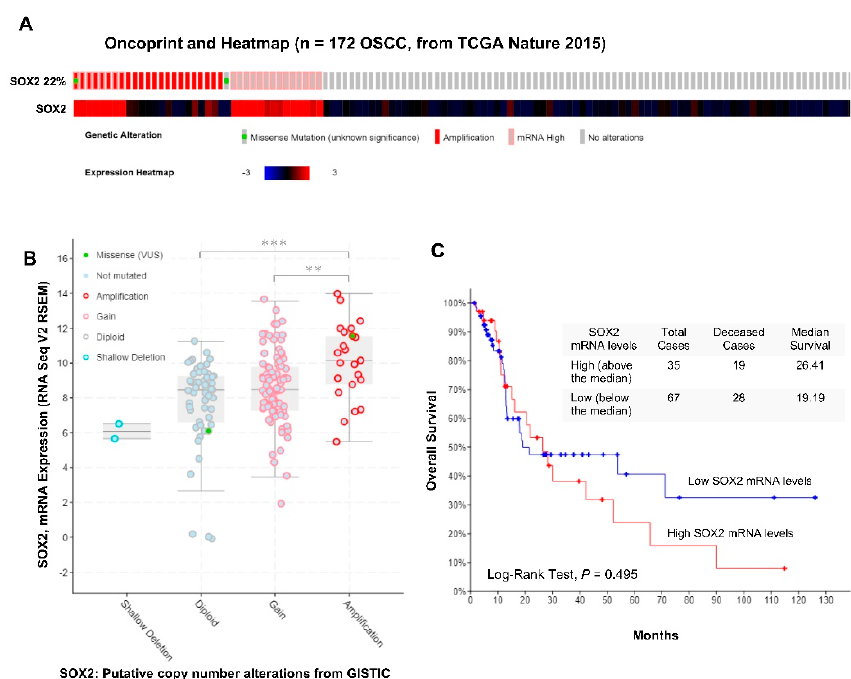
Figure 4. In silico analysis of mRNA expression and copy number alterations of SOX2 in the subset of 172 oral squamous cell carcinoma patients from The Cancer Genome Atlas (TCGA) Head and Neck Squamous Cell Carcinoma cohort [23] using the platform cBioPortal. ( A ) Oncoprint and heatmap representations showing the percentage of cases with SOX2 gene amplification, mutation, and mRNA up-regulation. ( B ) SOX2 mRNA expression analysis in relation to the copy number alterations of SOX2 gene (RNA seq V2 RSEM) values were Log2 transformed ( y -axis). Whiskers plot (min. to max.) with median values; ** P < 0.01 and *** P < 0.001, one-way ANOVA, Tukey’s test. ( C ) Kaplan–Meier survival curves categorized by SOX2 mRNA expression (RNA seq V2 RSEM, z-score threshold ± 2) dichotomized as high mRNA levels (above the median) versus low mRNA levels (below the median), P -value estimated using the log-rank test.